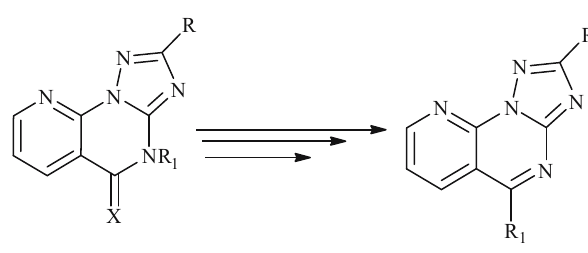
Scheme 1: The synthetic route of the target pyridotriazolopyrimi - dines ( 1 – 6 ) .